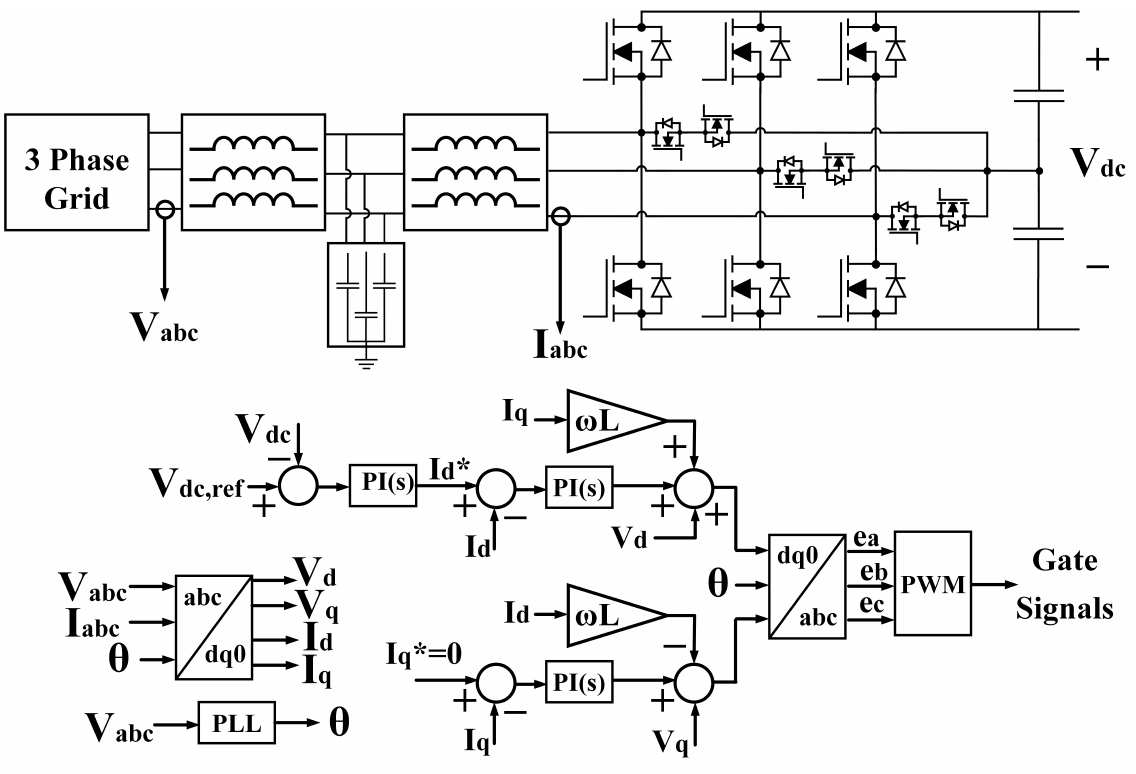
Figure 10. Decoupled current control for boost type active rectifier/inverters. The T-type inverter is given as an example. It can be any boost-type